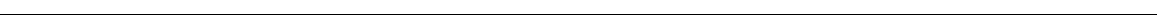
Fig. 1 In vivo role of Aggf1 in ER stress, cardiac apoptosis, and hypertrophy. TAC models for cardiac hypertrophy and heart failure were created for both wild-type and Aggf1 + / − male mice and characterized 6 weeks after surgeries. Sham, the same surgical procedure as TAC but without aortic constriction. a Representative H&E staining images of heart sections ( n = 12/group). Scale bar , 1 mm. b LVEF and LVFS ( n = 12/group, * P < 0.05, ** P < 0.01). c Ratios of heart weight to body weight ( n = 12/group, ** P < 0.01) and lung weight to body weight ( n = 12/group, * P < 0.05). d ELISA assays for the plasma ANF level ( n = 12/group, ** P < 0.01). e Cross-sectional diameter ( µ m) of cardiomyocytes ( n = 12/group, * P < 0.05). f Quantitative analysis of TUNEL-positive myocardial cells ( n = 6/group, ** P < 0.01). g Western blot analysis for markers for apoptosis ( n = 6/group, * P < 0.05, ** P < 0.01). h Western blot analysis for ER stress signaling markers using cardiac protein extracts, including cATF6 and sXBP1 ( n = 6/group, * P < 0.05, ** P < 0.01). Data are presented as the mean ± s.d. from at least three independent experiments. Statistical analysis was carried out by a Student ’ s two-tailed t